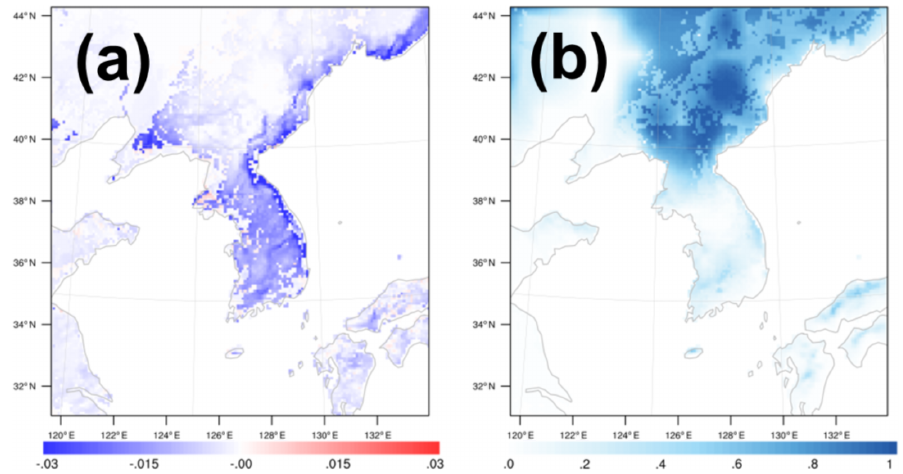
Figure 12. (a) Difference of the soil moisture (m 3 m − 3 ) (rRSL–rCTL) and (b) snow cover (%) of rCTL. The results are averaged over a period of 1 month and masked out over the ocean.